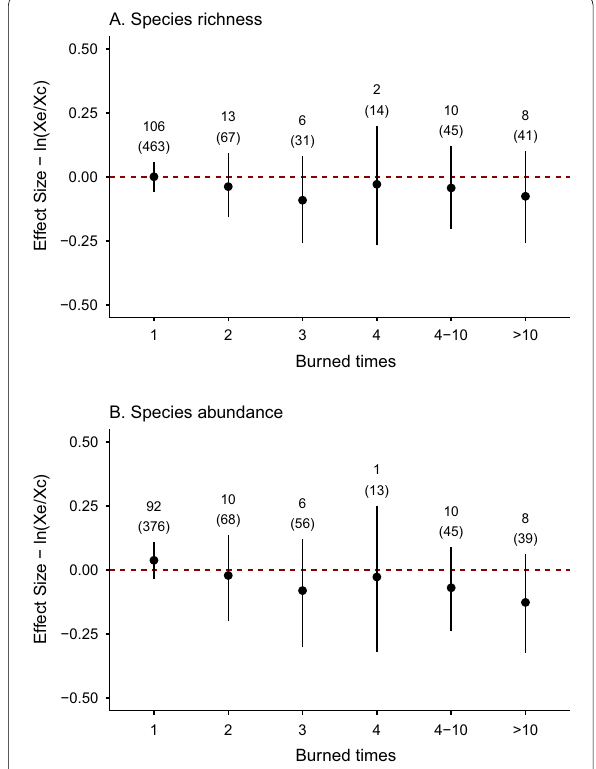
Fig. 6 Effect of fire regime—frequency—on the richness ( A ) and abundance ( B ) of species. The frequency is measured as the number of fire events in the study zone. The length of the lines represents the 95% confidence intervals. The numbers above dots represent the numbers of studies, and within parenthesis, the number of study pseudo‑replicas pooled to estimate the effect